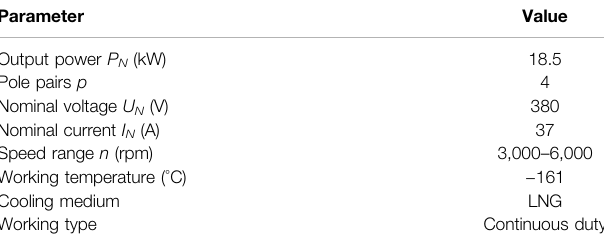
TABLE 1 | 18.5 kW CPMSM prototype